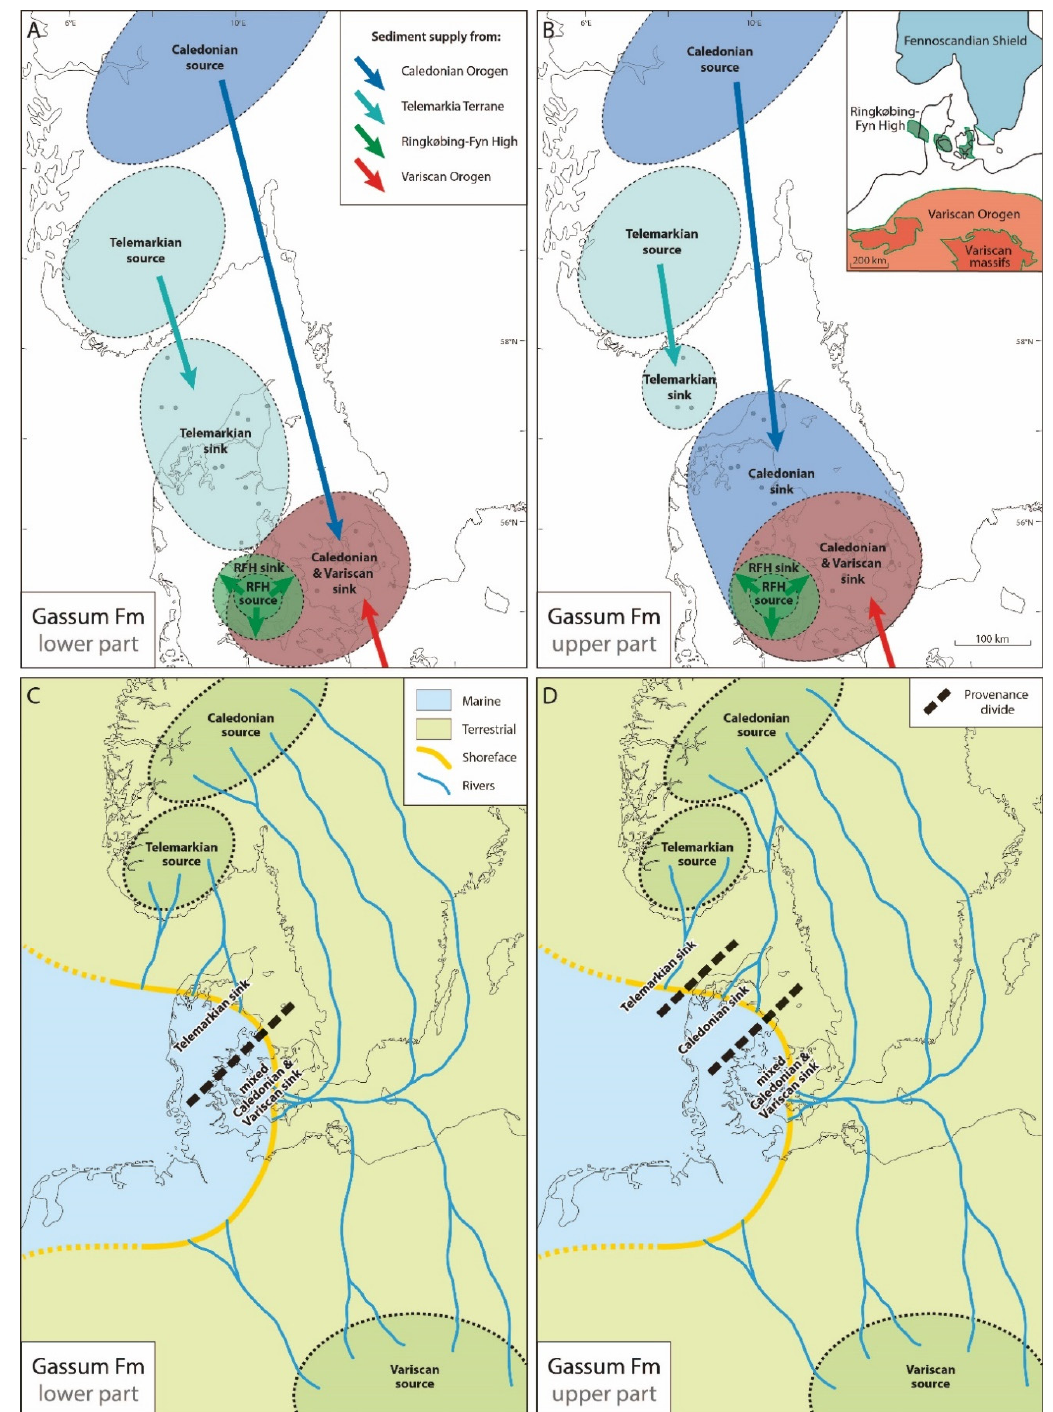
Figure 11. Provenance of the lower ( A ) and upper ( B ) parts of the Gassum Formation showing the location of the primary source areas (Caledonian, Sveconorwegian, and Variscan) and the minimum extend of their sinks as evident from zircon U-Pb data from wells in the Norwegian–Danish Basin and the northern North German Basin. Sediment was locally supplied from exposed parts of the Ringkøbing–Fyn High. Tentative paleogeographic reconstructions of these scenarios are shown for the lower ( C ) and upper (D ) parts of the formation, where the primary difference is which of the Fennoscandian source areas that supplied most sediment to the basin. They represent snapshots since the coastline moved back and forth due repeated transgressions and regressions.